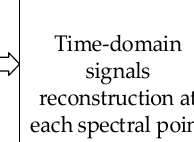
Figure 11. Spectrum calculation setup.